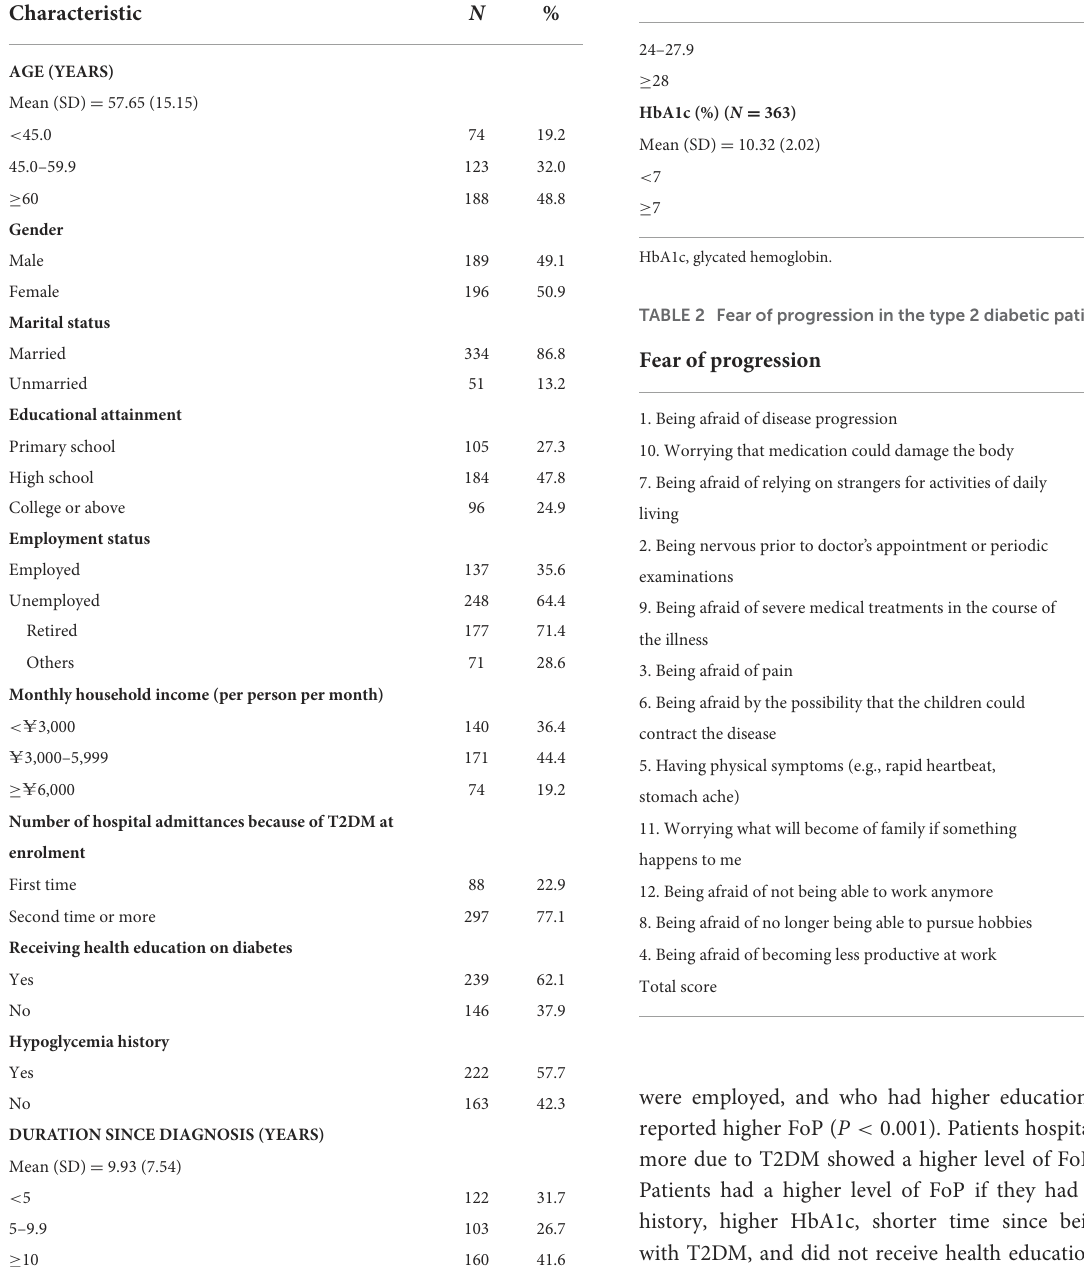
multiple linear regression model. And the best-fit multiple linear regression model included five variables (Table 4).